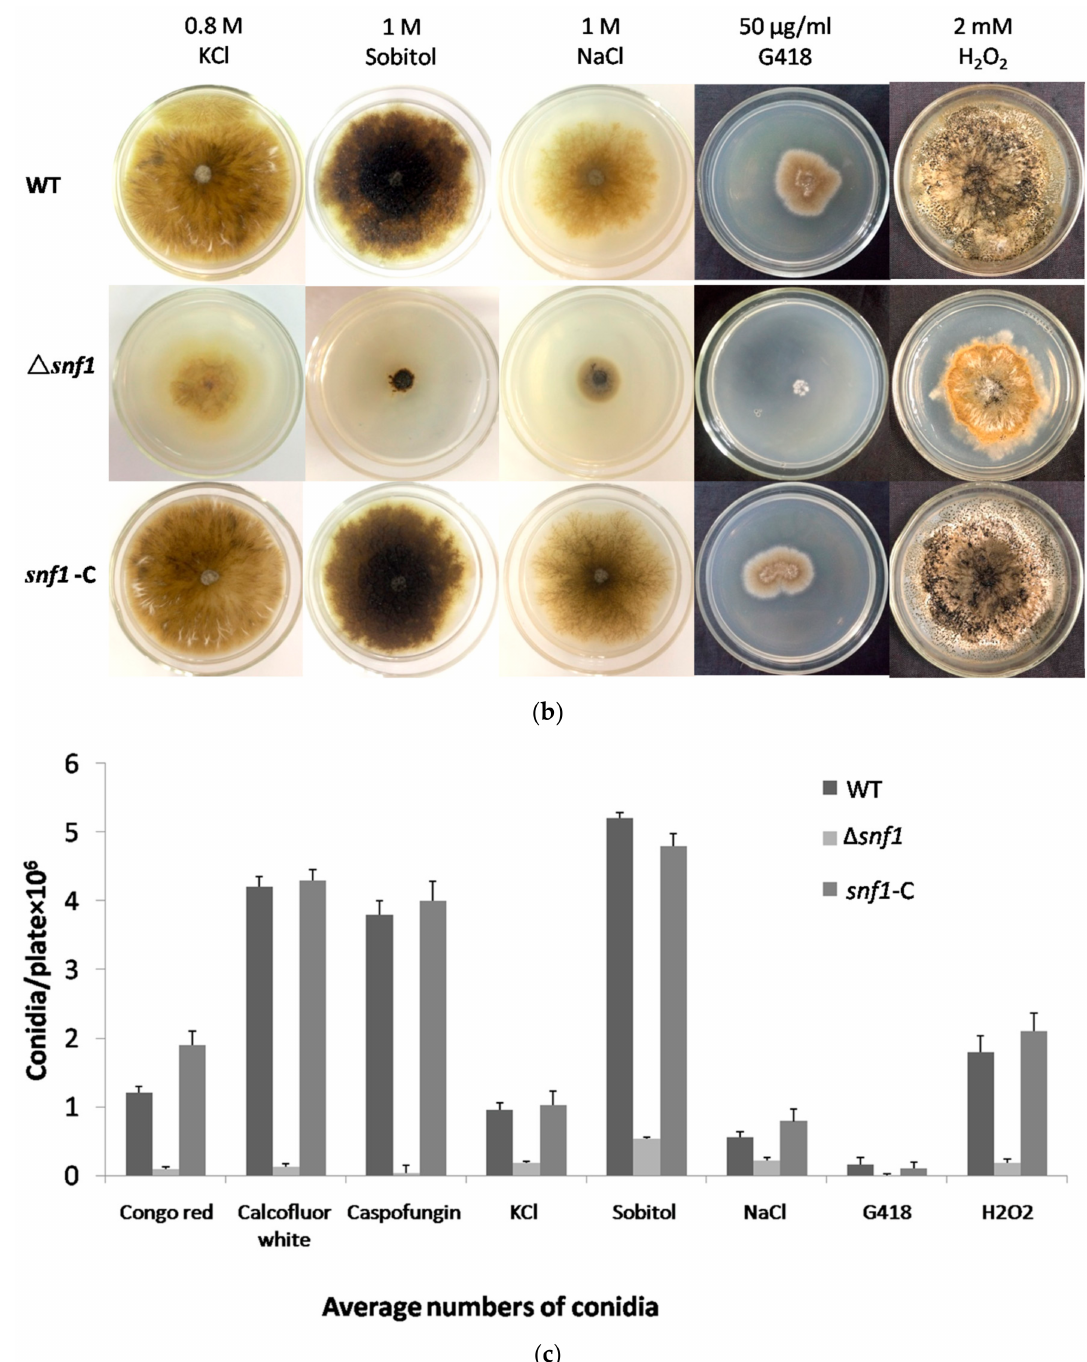
Figure 4. Susceptibility tests for ∆ snf1 to adverse culture conditions. ( a ) Stress tolerance to cell wall inhibitors, Congo red, calcofluor white and caspofungin on PDA. PDA without the supplements served as the control. Conidiation and vegetative growth of ∆ snf1 was significantly affected; ( b ) Stress tolerance to osmotic pressure generated by high concentration of KCl, NaCl and sorbitol. Growth test under oxidative stress (2 mM H 2 O 2 ), plus G418 Susceptibility tests for ∆ snf1 ; ( c ) The number of conidia produced by NK17, ∆ snf1 and the complementation strain snf1 -C was determined in the indicated conditions and triplicate PDAs for each strain were incubated at 28 ◦ C for 168 h. Error bars represent standard